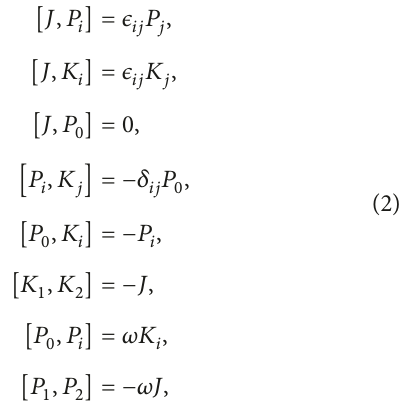
Table1:TheAdS,Minkowskian,anddS(2+1)Dspacetimesand4Dspacesoftime-likelinesaccordingtothecurvature/cosmologicalconstant 𝜔 = −Λ . 𝜔,Λ Spacetime S